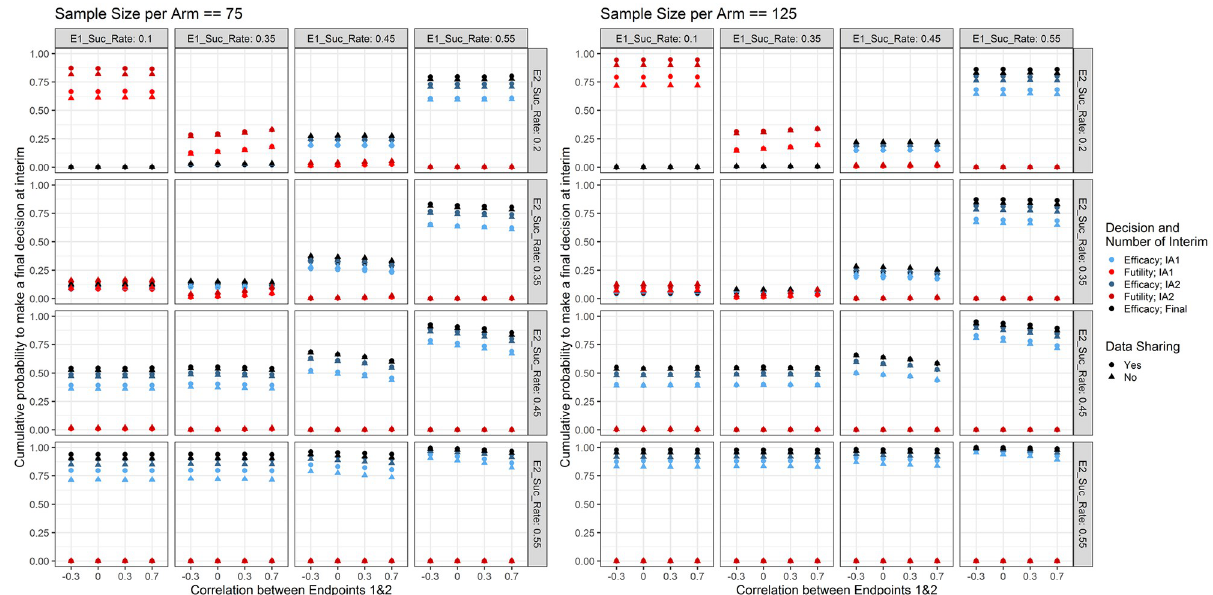
Fig 6. Cumulative probabilities to make a decision early (i.e. making an early efficacy or futility decision either at the first or second interim analysis) with respect to the response rate for endpoint 1 (E1_Suc_Rate; columns), the response rate for endpoint 2 (E2_Suc_Rate; rows), the correlation between the two endpoints (x-axis), the type of data sharing used (point shape) and the planned sample size per cohort (left panel 150 and right panel 250).